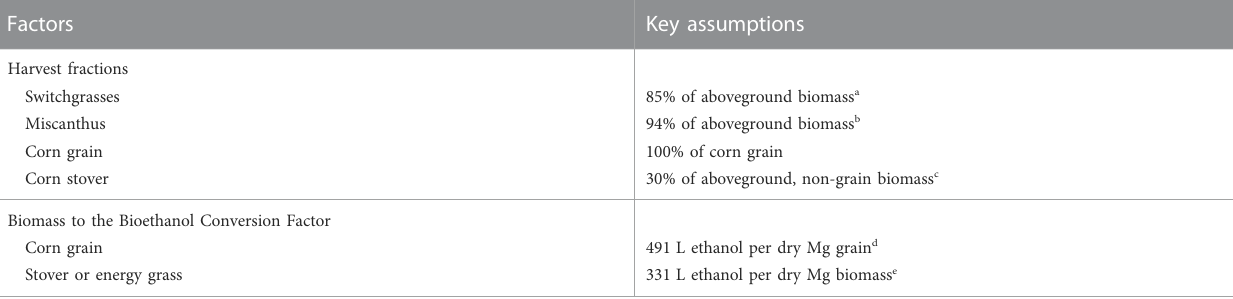
TABLE 1 Key assumptions of harvest fractions and biomass-to-bioethanol conversion factors (i.e., the volume of bioethanol produced per unit biomass). Factors